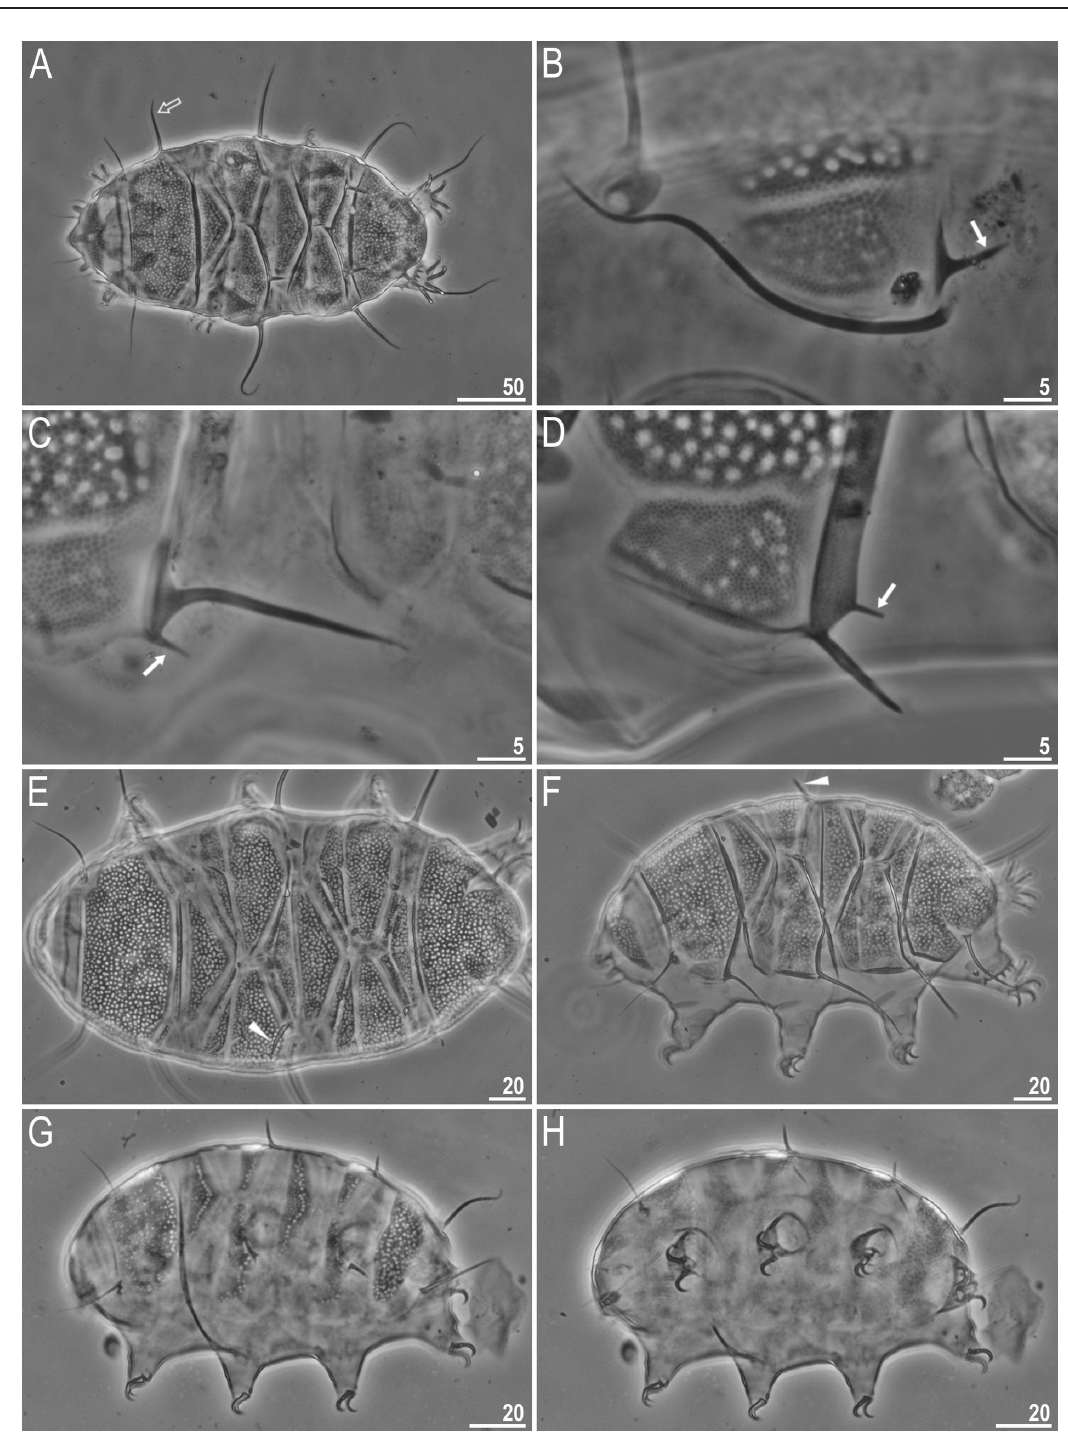
Fig. 7. Echiniscus quadrispinosus Richters, 1902. A–F . Examples of different chaetotaxy found in examined population. A* . Female with appendage B present only on one side of the body (empty arrow) (chaetotaxy: A-B-C-C d -D-D d -E ). B–D . Close-up to the spines near the base of normally developed appendages B (filled arrows). E–F . Presence of appendage C d only on one side of the body (filled arrowheads) and lack of appendages D d (chaetotaxy: A-B-C-C d -D-E ). G . Larvae, dorsal view (chaetotaxy: A-C d -D d -E ). H . Larvae, ventral view. * = manually assembled deep-focus image. All PCM. Scale bars in micrometres